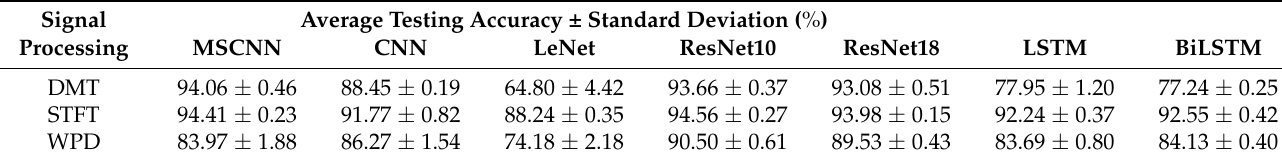
Table 9. Experimental results of the gear datasets.